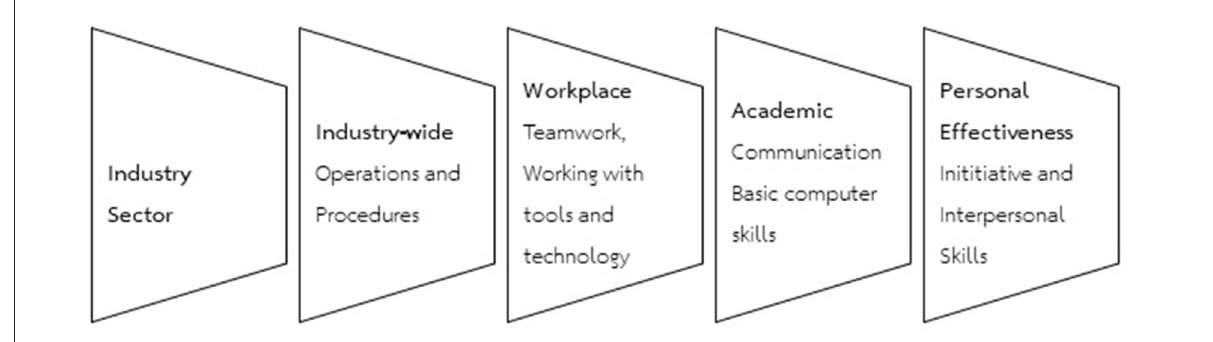
FIGURE1 Hospitality and Tourism Competencies summarised from the ETA model (Employment Training Administration.,